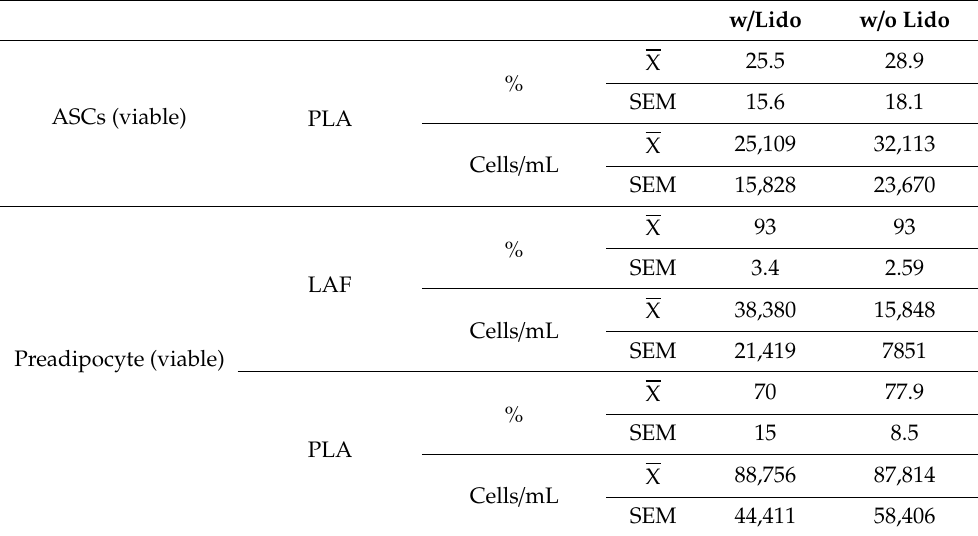
Figure 5. The graphs show the statistical comparison of the relative distribution ( n = 11) and absolute number ( n = 10) of all cells ( a , b ), ASCs ( c , d ), and preadipocytes ( e , f ) inside the SVF of the fluid (LAF) and fatty (PLA) portion w/ and w/o lidocaine. Samples of each patient are marked in every group. The mean and standard error of the mean in each group is shown. For multiple comparisons, the Kruskal–Wallis test was used. The α -value was at 0.05. Patients with a BMI ≥ 30 are shown in red. Table 2. Mean (x) and standard error of the mean (SEM) of alive ASCs and alive preadipocytes (Zombie-) in the absolute number per mL and as a percentage of all counted stem cells and preadipocytes ( n = 5